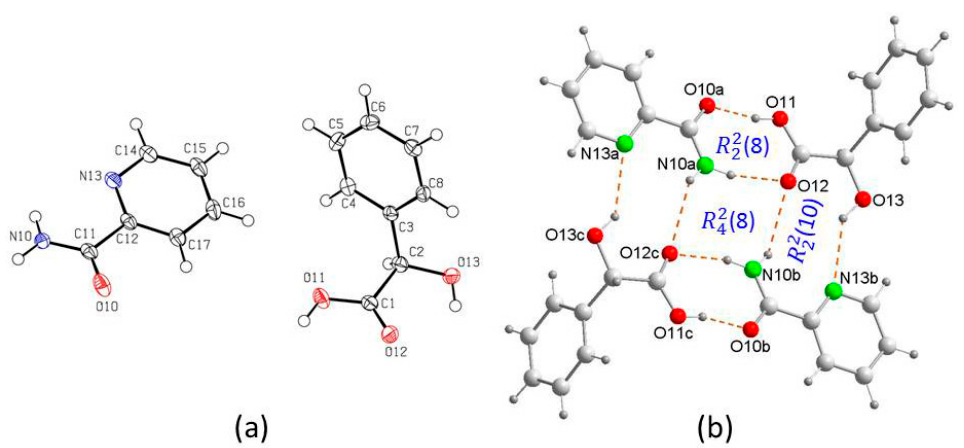
Figure 1. ( a ) Asymmetric unit of pic - D-H 2 ma and ( b ) four-membered supramolecular unit in the crystal structure of pic - D-H 2 ma (1:1) co-crystal.